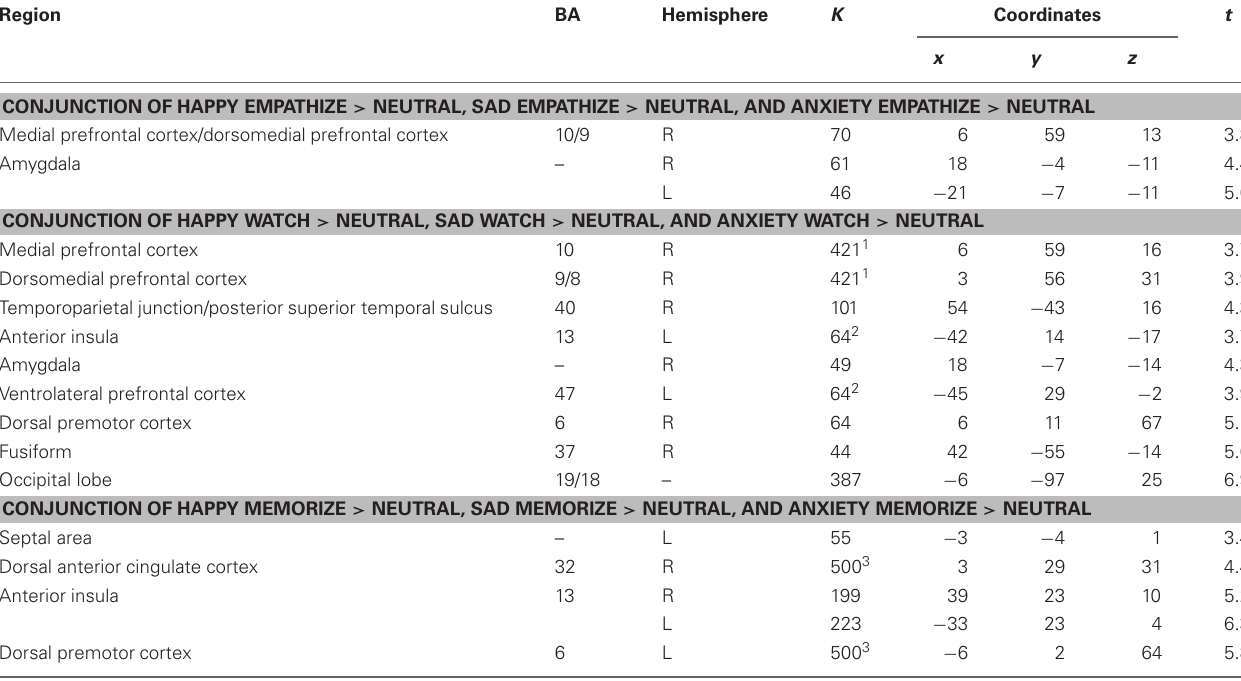
Table 2 | Neural regions that were commonly activated during happiness, sadness, and anxiety for empathize compared to neutral, watch compared to neutral, and memorize compared to